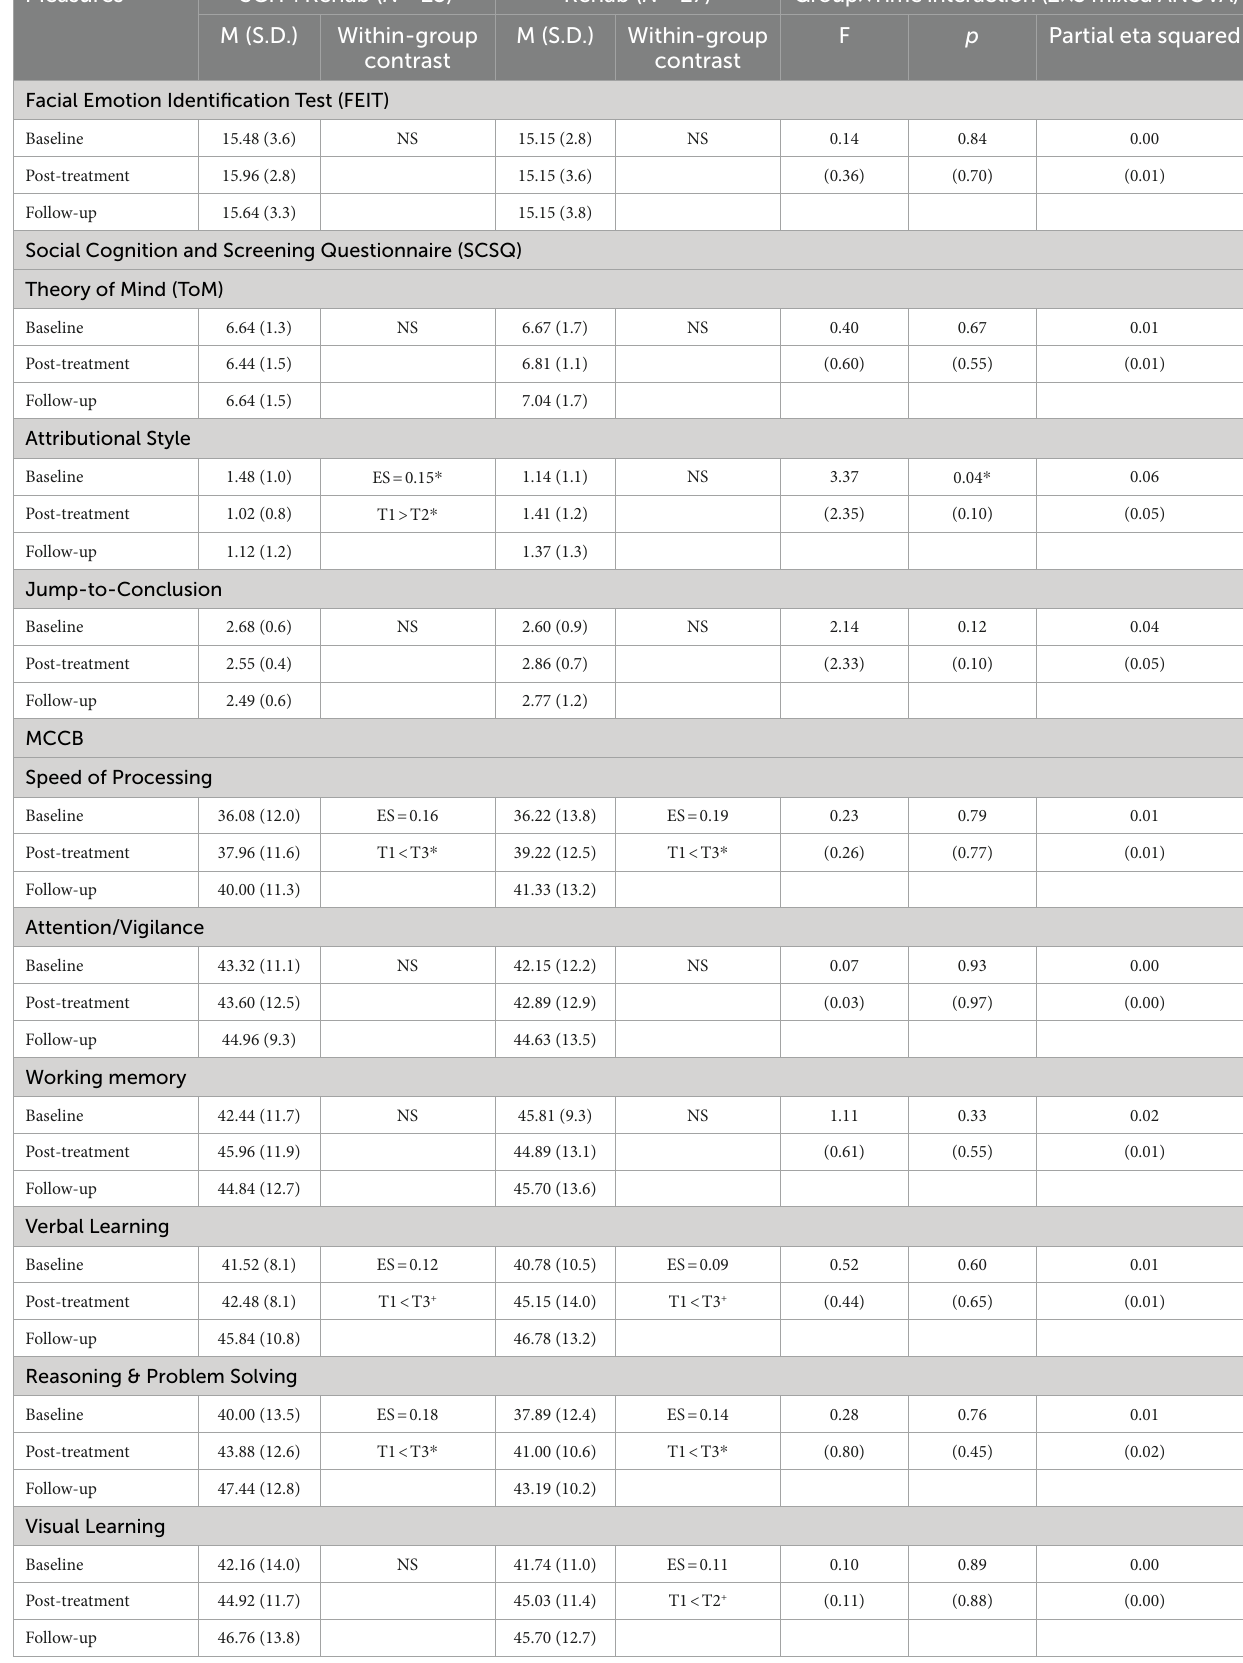
TABLE 4 Comparison of social cognitive and neurocognitive measures between SCIT + Rehab completers and Rehab group at T1, T2 and T3. Measures SCIT + Rehab ( N = 25) Rehab ( N = 27) Group × Time interaction (2 × 3 mixed ANOVA) M (S.D.) Within-group M (S.D.) Within-group F p Partial eta squared contrast contrast Facial Emotion Identification Test